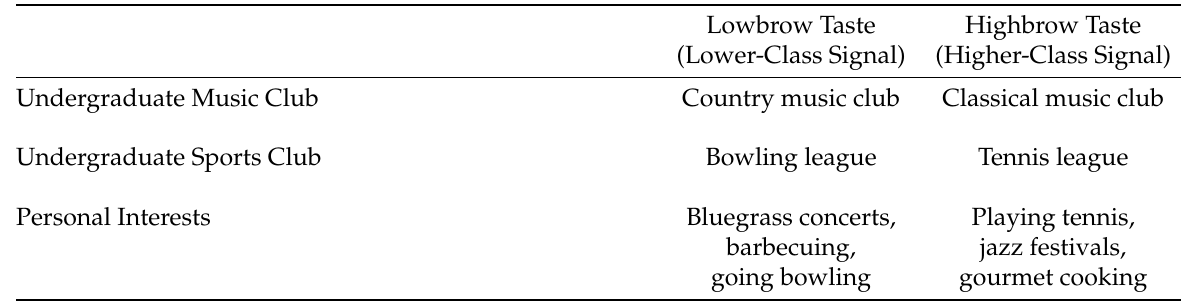
Table 2: Cultural signals of